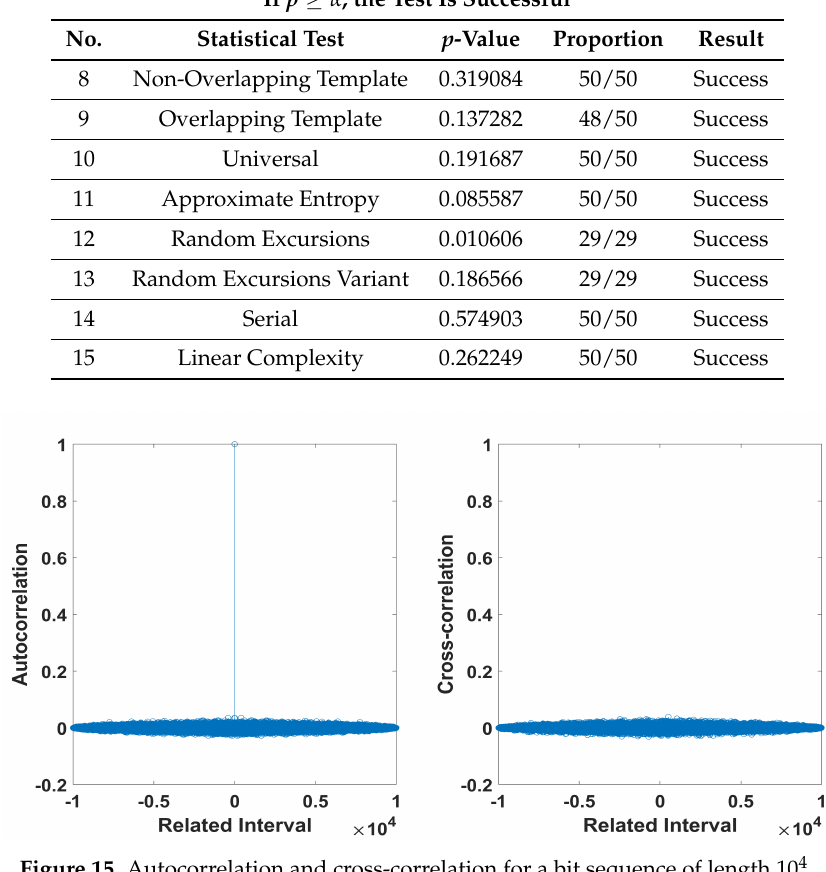
Figure 15. Autocorrelation and cross-correlation for a bit sequence of length 10 4 . Table 2. Key space of different